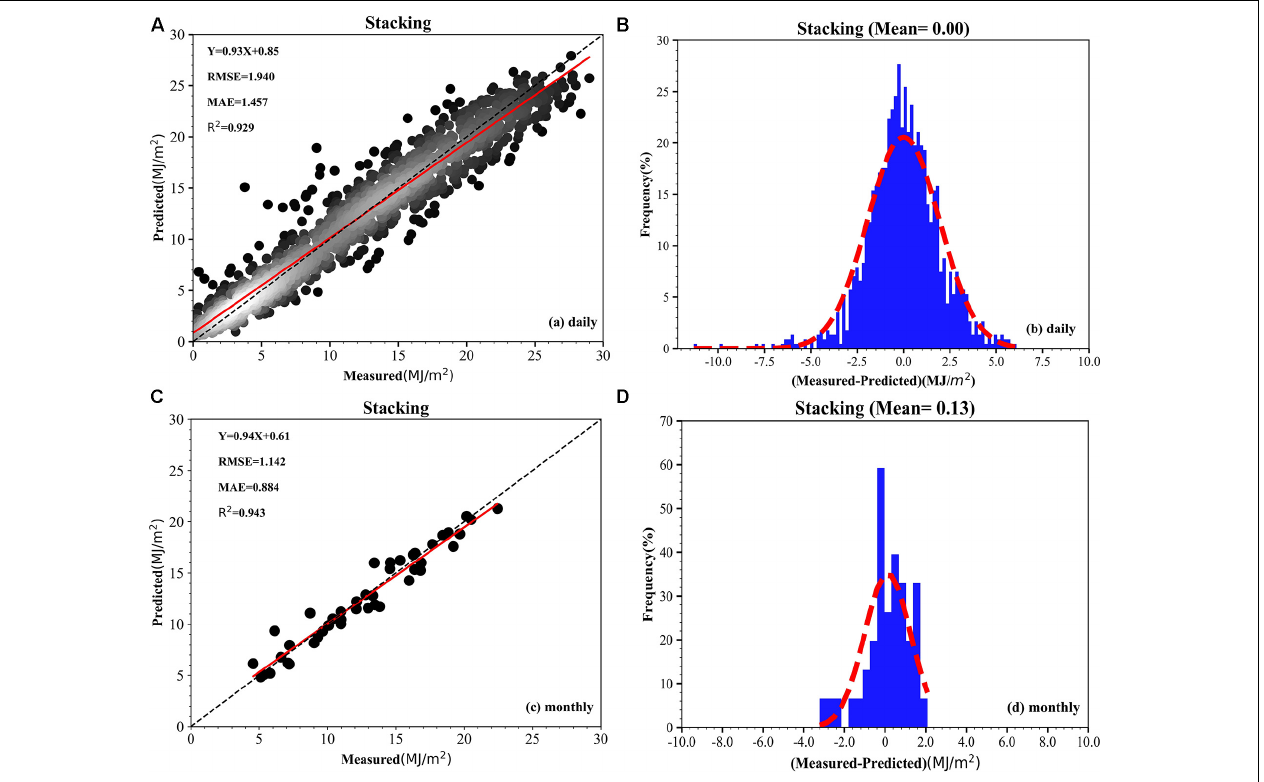
FIGURE 10 | (A–D) Scatter plot and distribution of deviation of the prediction results of the stacking model.